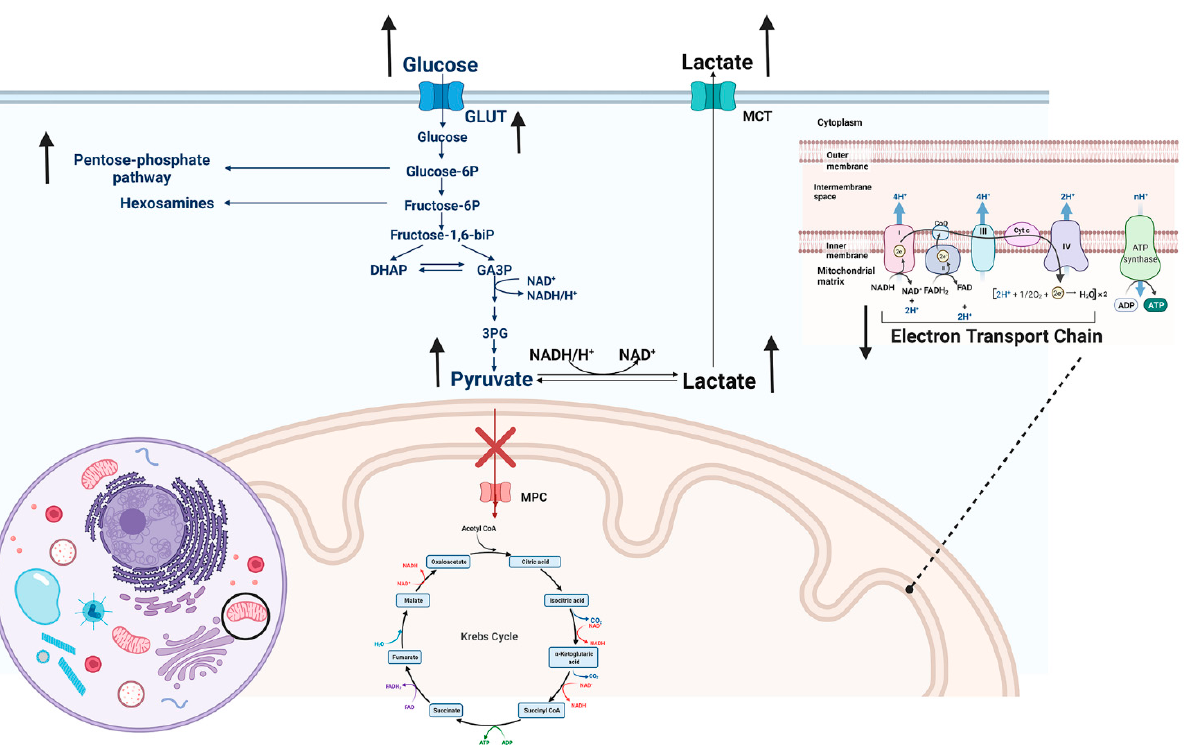
Figure 1. Downstream of HIF-1 α activation. Created with BioRender.com (accessed on 22 April